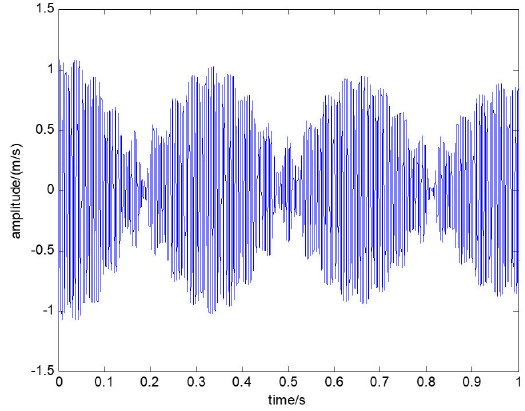
Figure 16. Horizontal speed response.